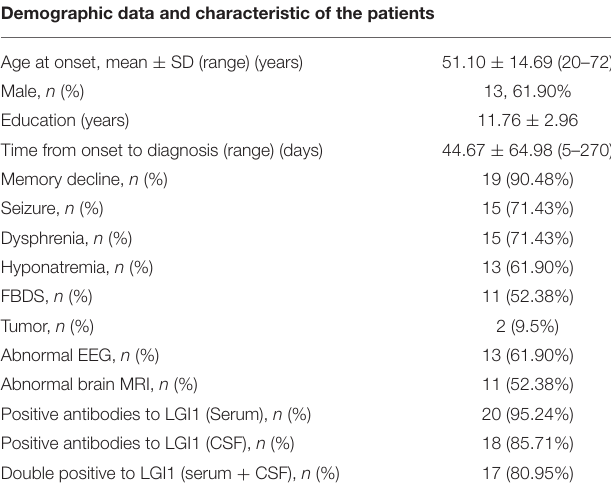
TABLE 1 | Demographic data and patient characteristics. Demographic data and characteristic of the